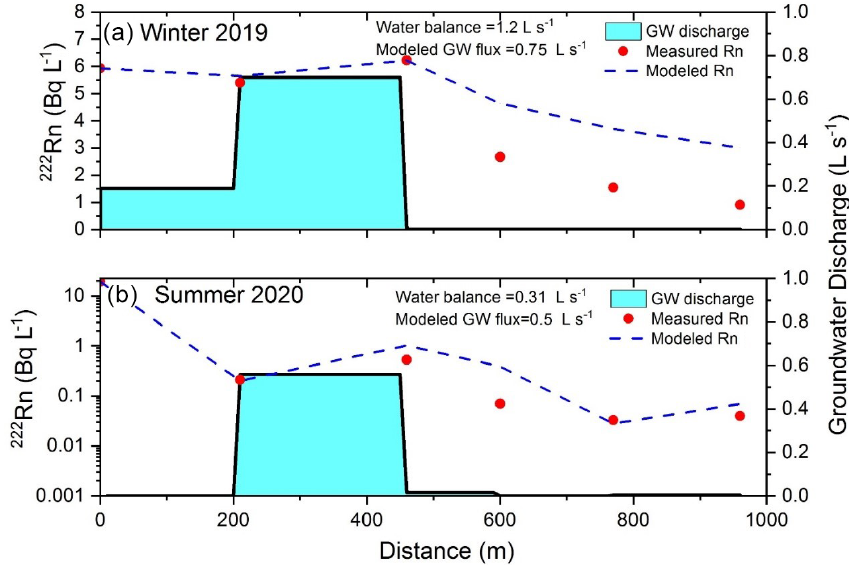
Figure 6. 222 Rn concentrations in the stream water (measured and modeled) and groundwater discharge levels during a the winter (January 2019) campaign and b the summer (September 2020) campaign. Groundwater discharge during the winter campaign includes drain water discharge. Note that the most upstream summer sample was not considered representative of stream water (see Fig.